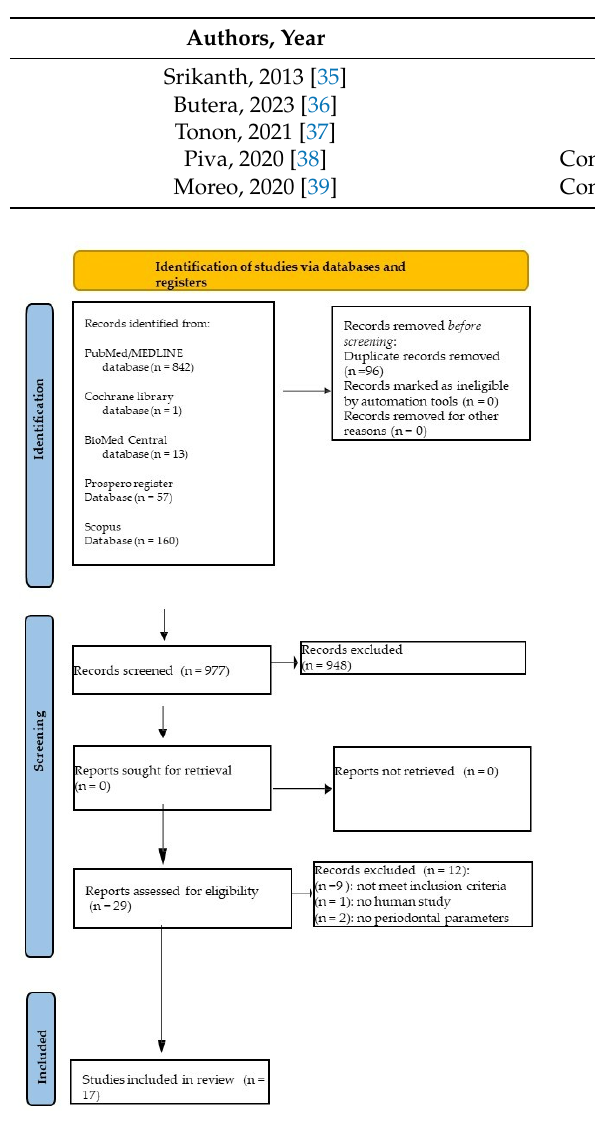
Figure 1. PRISMA flowchart of the screening